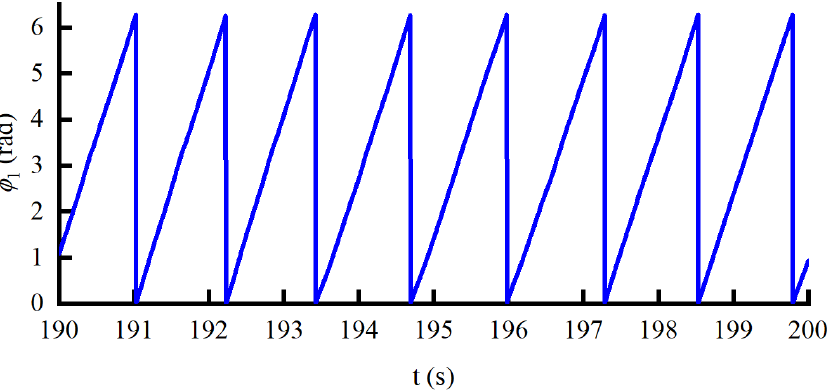
Figure 17. The phase curve under the HEIF-AO in the outer loop and the DOB in the inner loop.